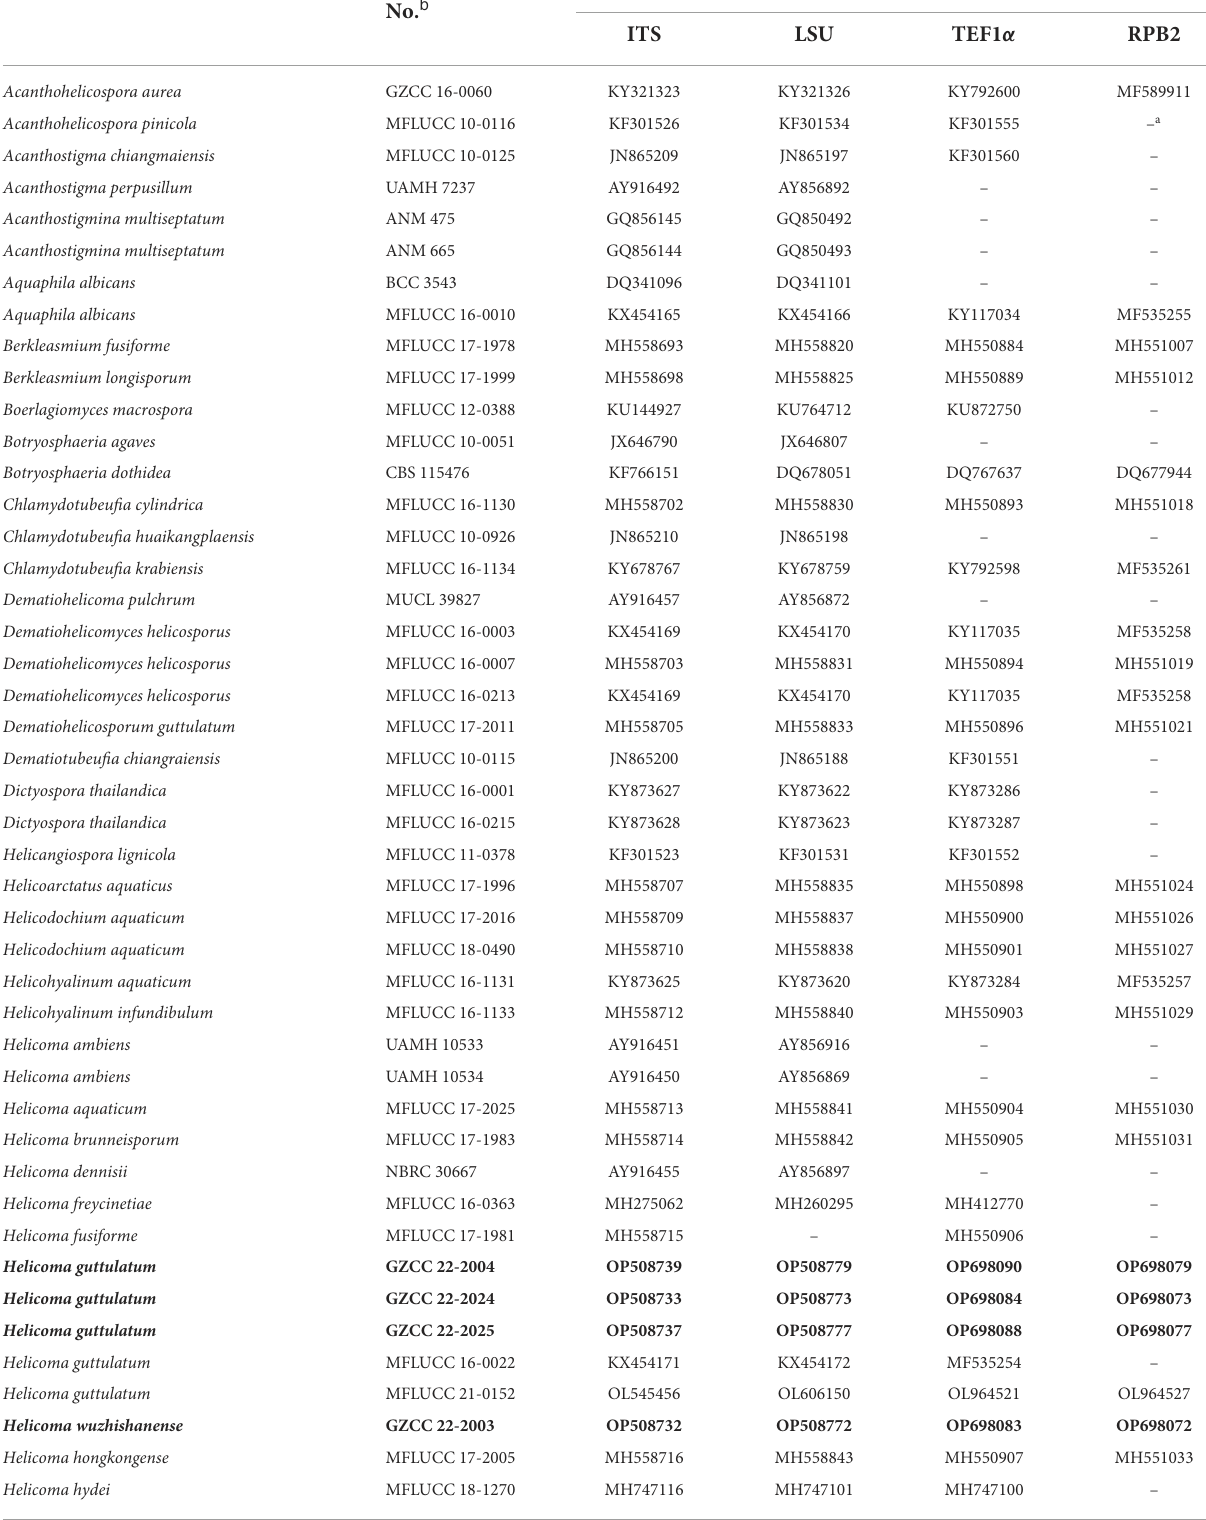
TABLE 1 Taxa used in this study and their GenBank accession numbers for ITS, LSU, RPB2, and TEF1 α DNA sequence data. Taxa Strain/Voucher GenBank accession No. b